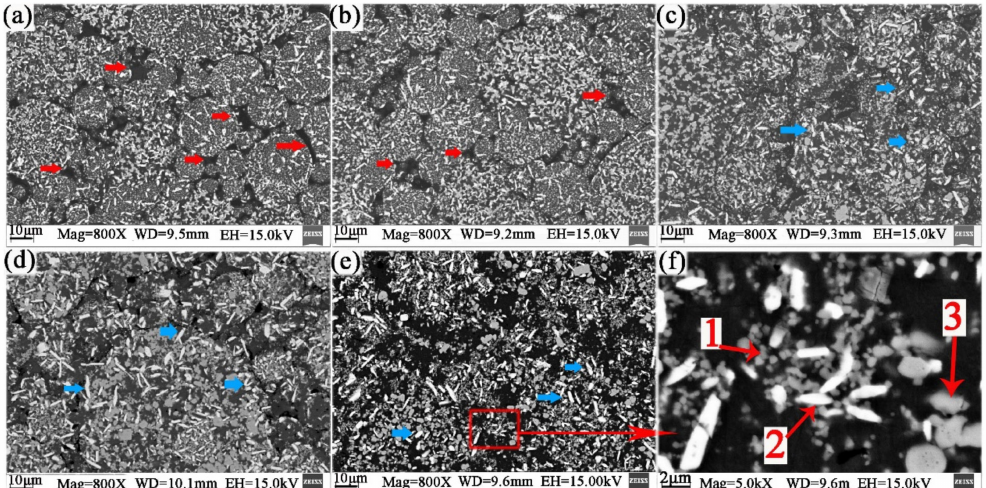
Figure 5. FESEM/BSE micrograph of the green and sintered samples with different sintering temperature: specimens were compacted with compaction energy of 1325 J and sintered at temperature, ( a ) 560 ◦ C ( b ) 580 ◦ C ( c ) 620 ◦ C ( d ) 640 ◦ C; and specimens were compacted with compaction energy of 1885 J and sintered at 640 ◦ C ( e , f ).